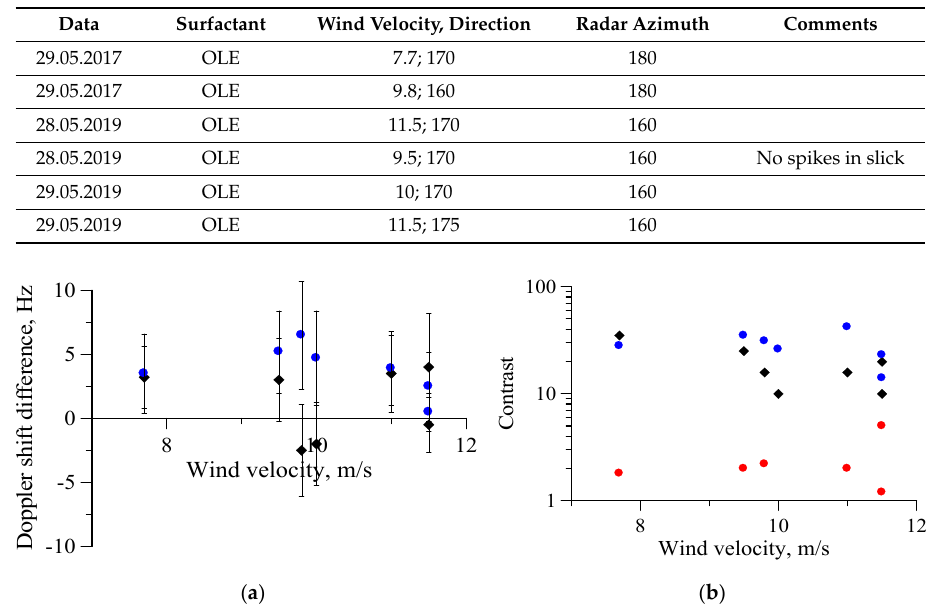
Figure 13. Doppler shift di ff erence in slick and non-slick zones ( a ) and contrasts vs. wind speeds ( b )